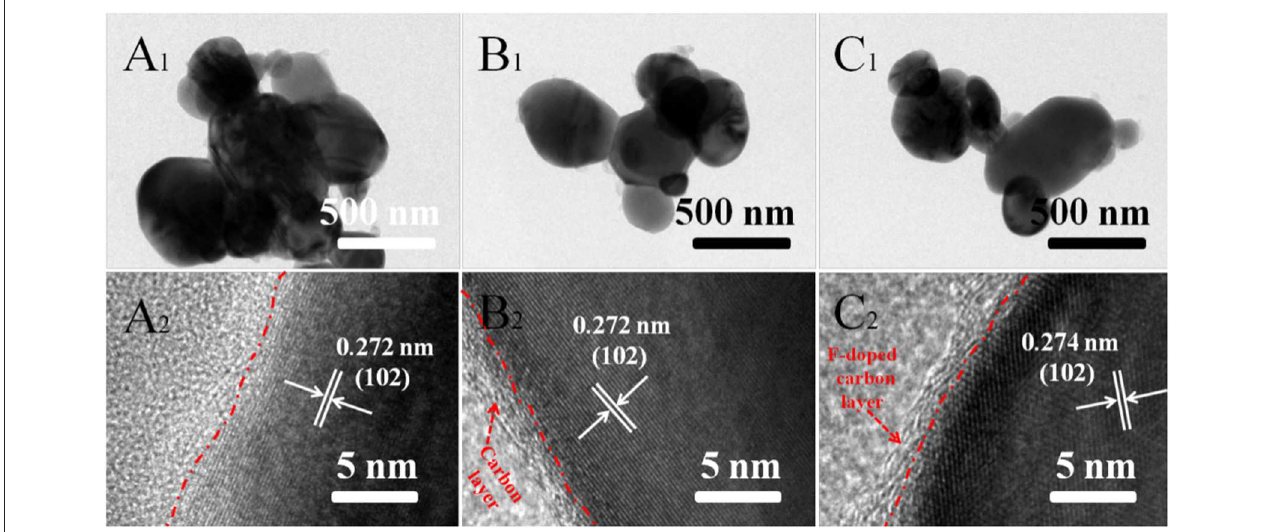
FIGURE 6 | TEM images and HRTEM images of pure LFP (A 1 ,A 2 ) , LFP/C (B 1 ,B 2 ) , and LFPF/CF (C 1 ,C 2 )